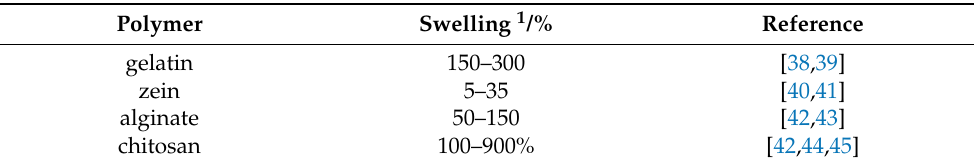
Table 2. Examples of eligible hygroscopic polymers for tissue engineering of transparent tissues, e.g., corneal transplant. The table does not lay any claim to